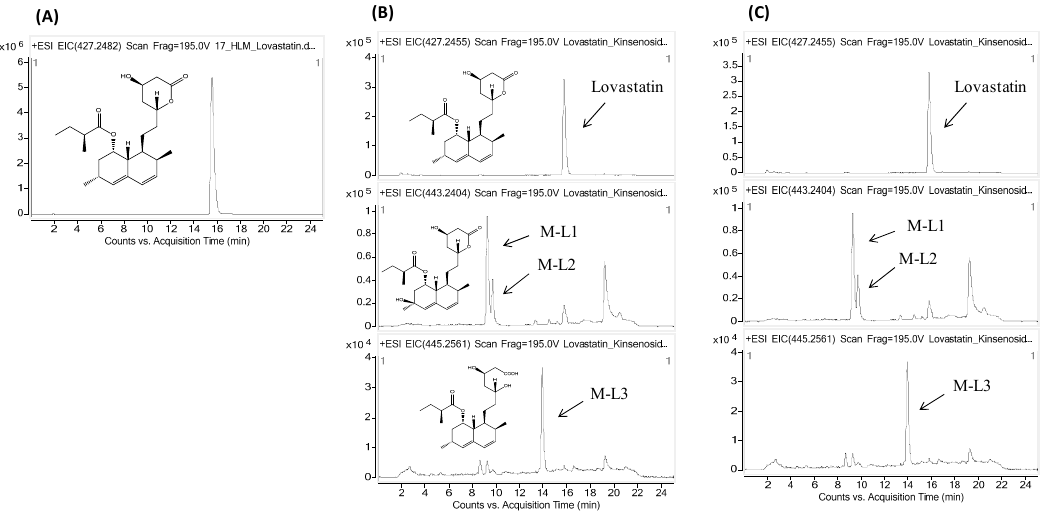
Figure 4. Representative EIC chromatograms for ( A ) lovastatin standard, and in human liver microsome samples ( B ) without kinsenoside (control) and ( C ) with kinsenoside.